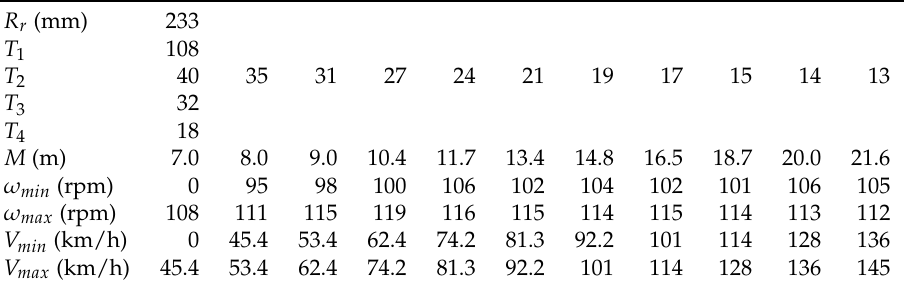
Table 1. Example of data from the developed